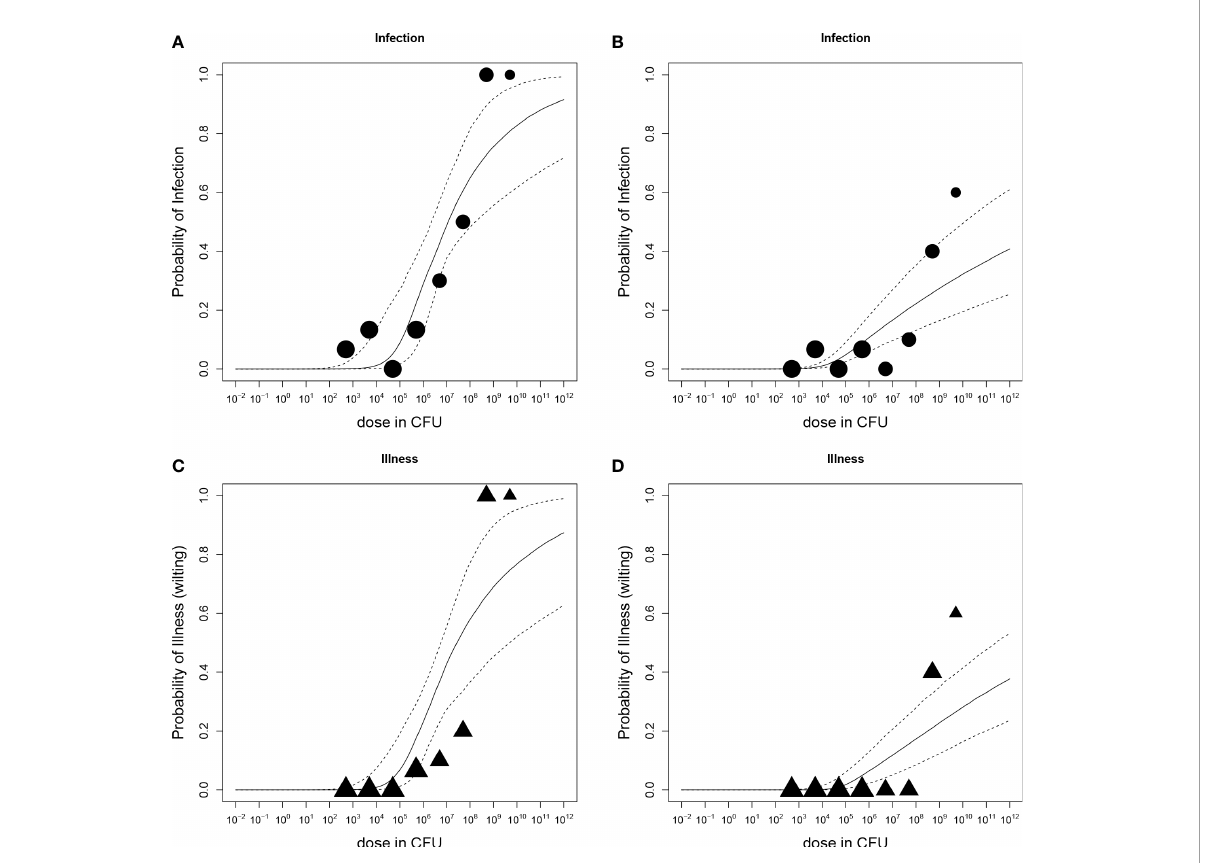
FIGURE 3 Dose-response relations of potato plants cv Kondor (A, C) or cv HB (B, D) and Ralstonia solanacearum ; A+B: Probability of infection (stem, root, or tuber) with increasing dose in colony forming units (CFU); (C, D) Probability of illness (wilting) with increasing dose. Each graph shows the median and 95% range of the probability of infection or illness, indicated by the dashed line, calculated by the dose-response model as a function of dose. Available data are shown as a bubble chart in which the symbol size is proportional to the number of plants challenged.